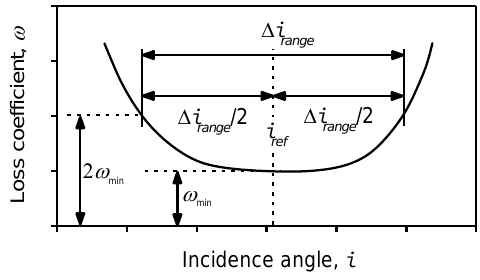
Figure 2. A schematic diagram for reference minimum-loss definition.